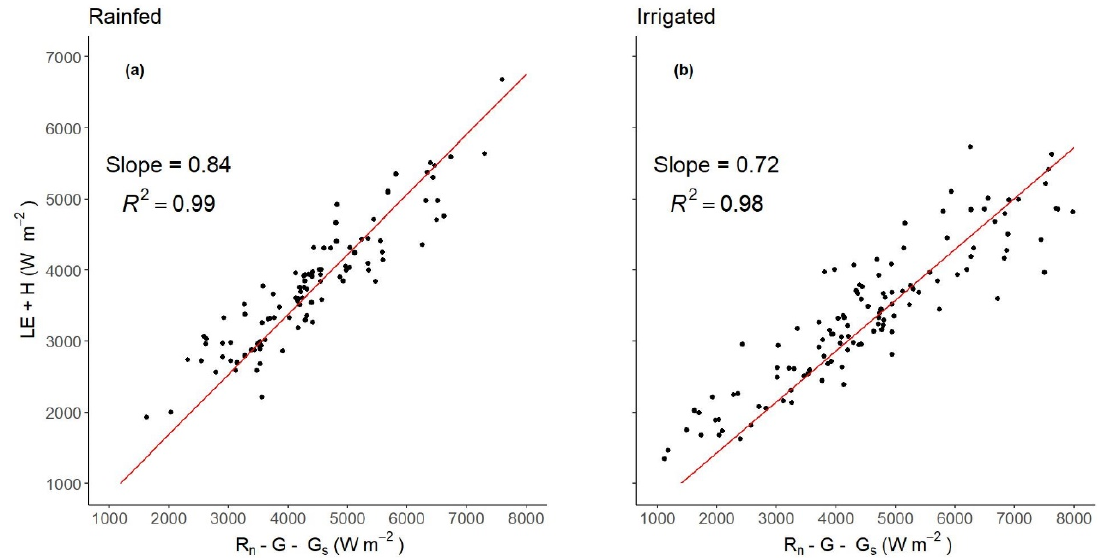
Figure 2. Energy balance closure for ( a ) Rainfed and ( b ) Irrigated sites.